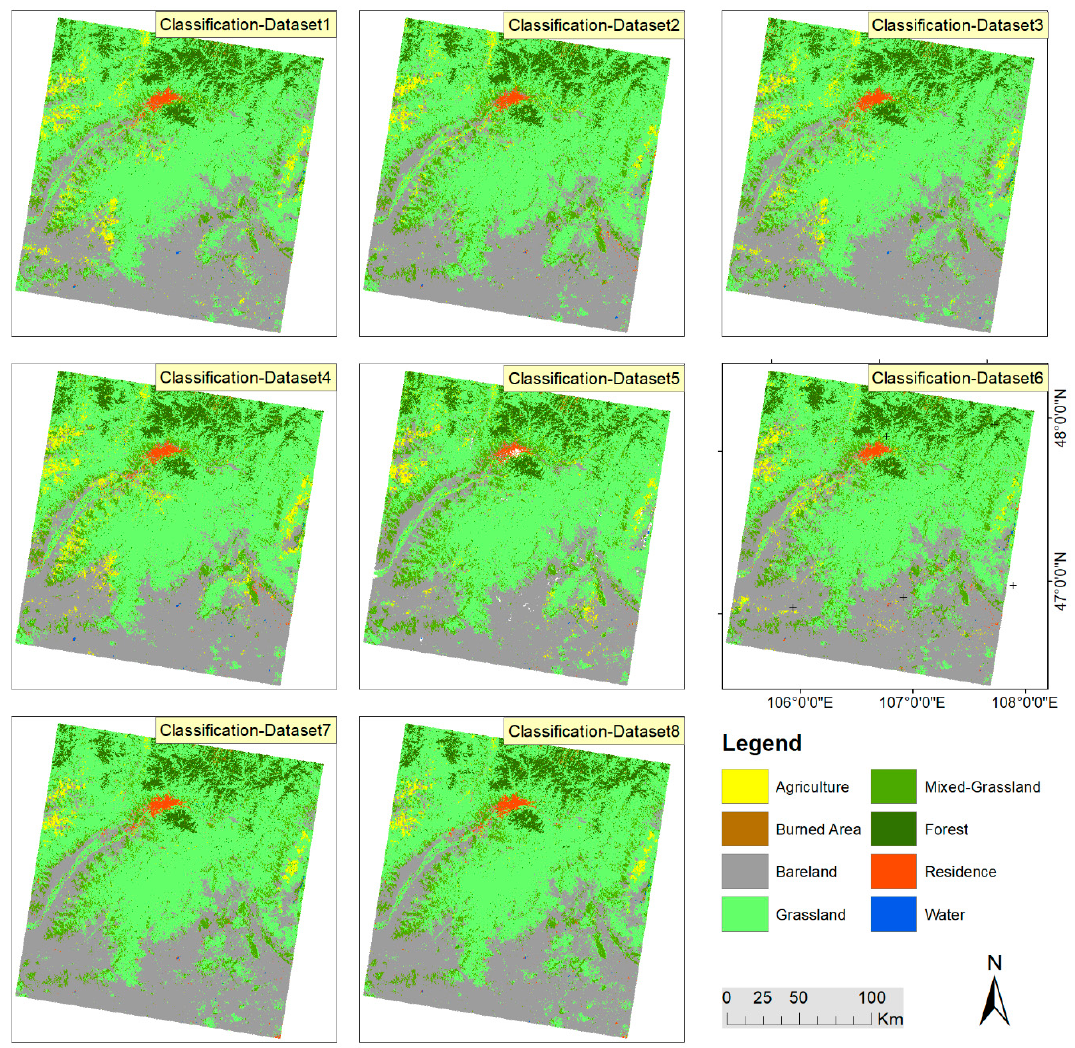
Figure 5. Land cover classification of the eight datasets.